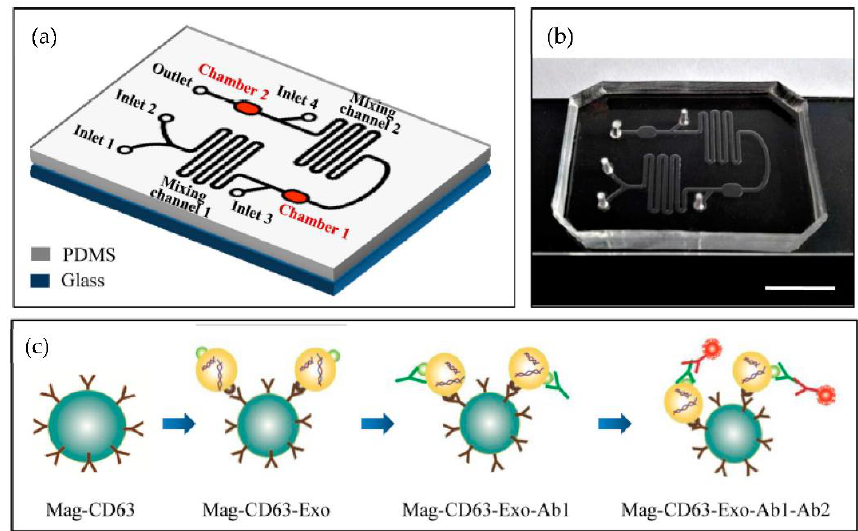
Figure 15. Chip design and principle for exosome capture and detection. ( a ) The microfluidic chip schematic representation. ( b ) Photo of the chip. The scale bar represents 1 cm. ( c ) Workflow for the immunomagnetic capture and detection of exosomes. (Reproduced from Fang S. et al. [80]. Copyright 2017, PLoS ONE).